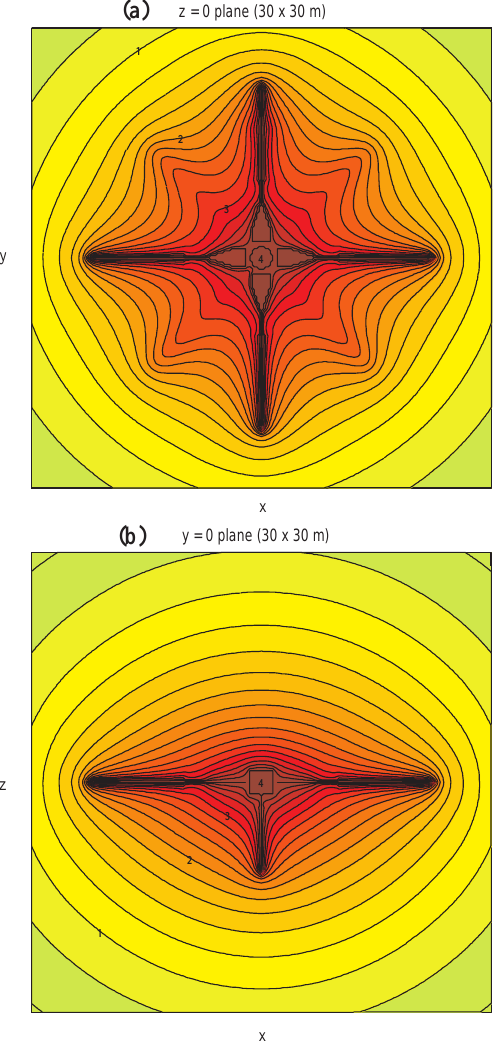
Fig. 2. Equipotential contours in V of the three-dimensional poten- tial distribution near Interball-2 for 8 s = 4V, and 8 bias = − 8V in different planes: (a) in the solar panels plane x − y , and (b) in a meridian plane x − z through the